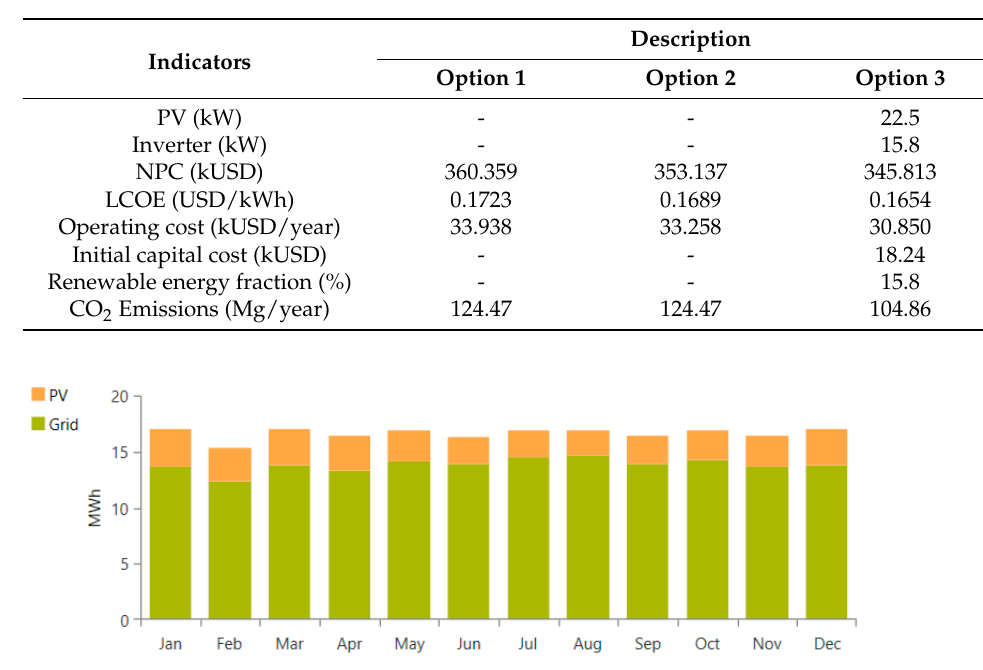
Table 5. Several indicators of economic analysis with different tariff options in the case study.